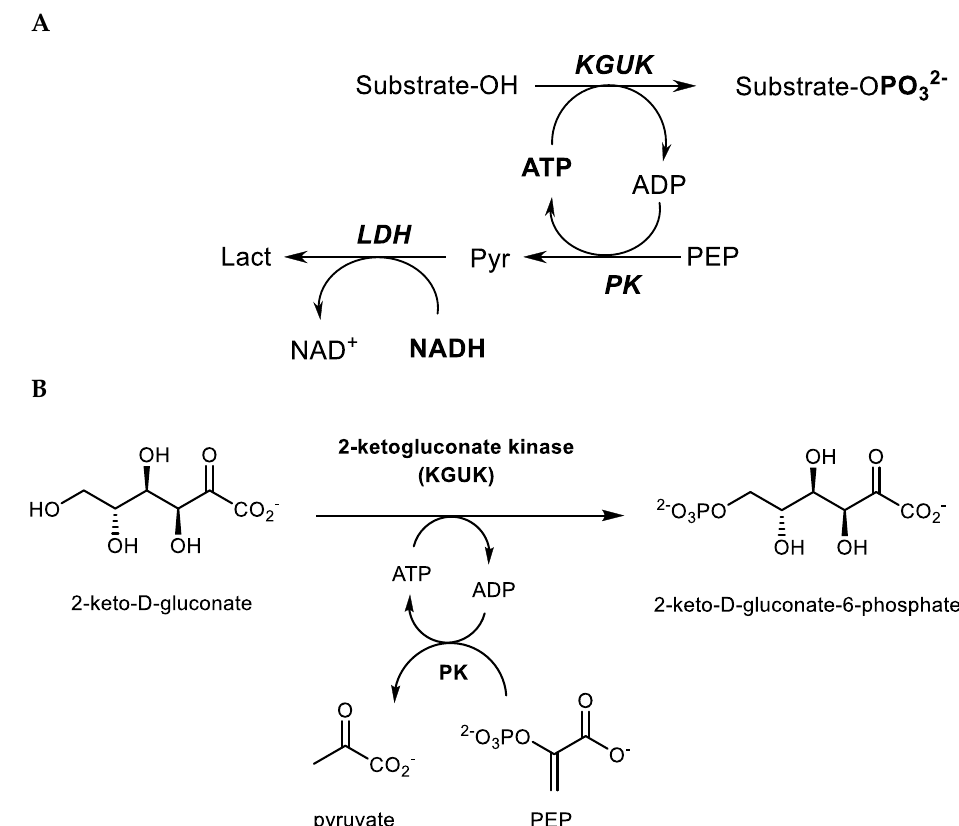
Figure 7. Phosphorylation reactions: analytical (assay) and practical (synthesis) scale. ( A ) KGUK activity assay. Substrate phosphorylation was measured with a coupled enzymatic system, where the decrease of NADH absorbance at 340 nm was directly proportional to substrate phosphorylation. PK: pyruvate kinase, PEP: phosphoenolpyruvate, pyr: pyruvate, lact: lactate, LDH: lactate dehydrogenase. ( B ) Biocatalytic orthogonal cascade for the synthesis of 2-ketogluconate-6-phosphate (KGP).